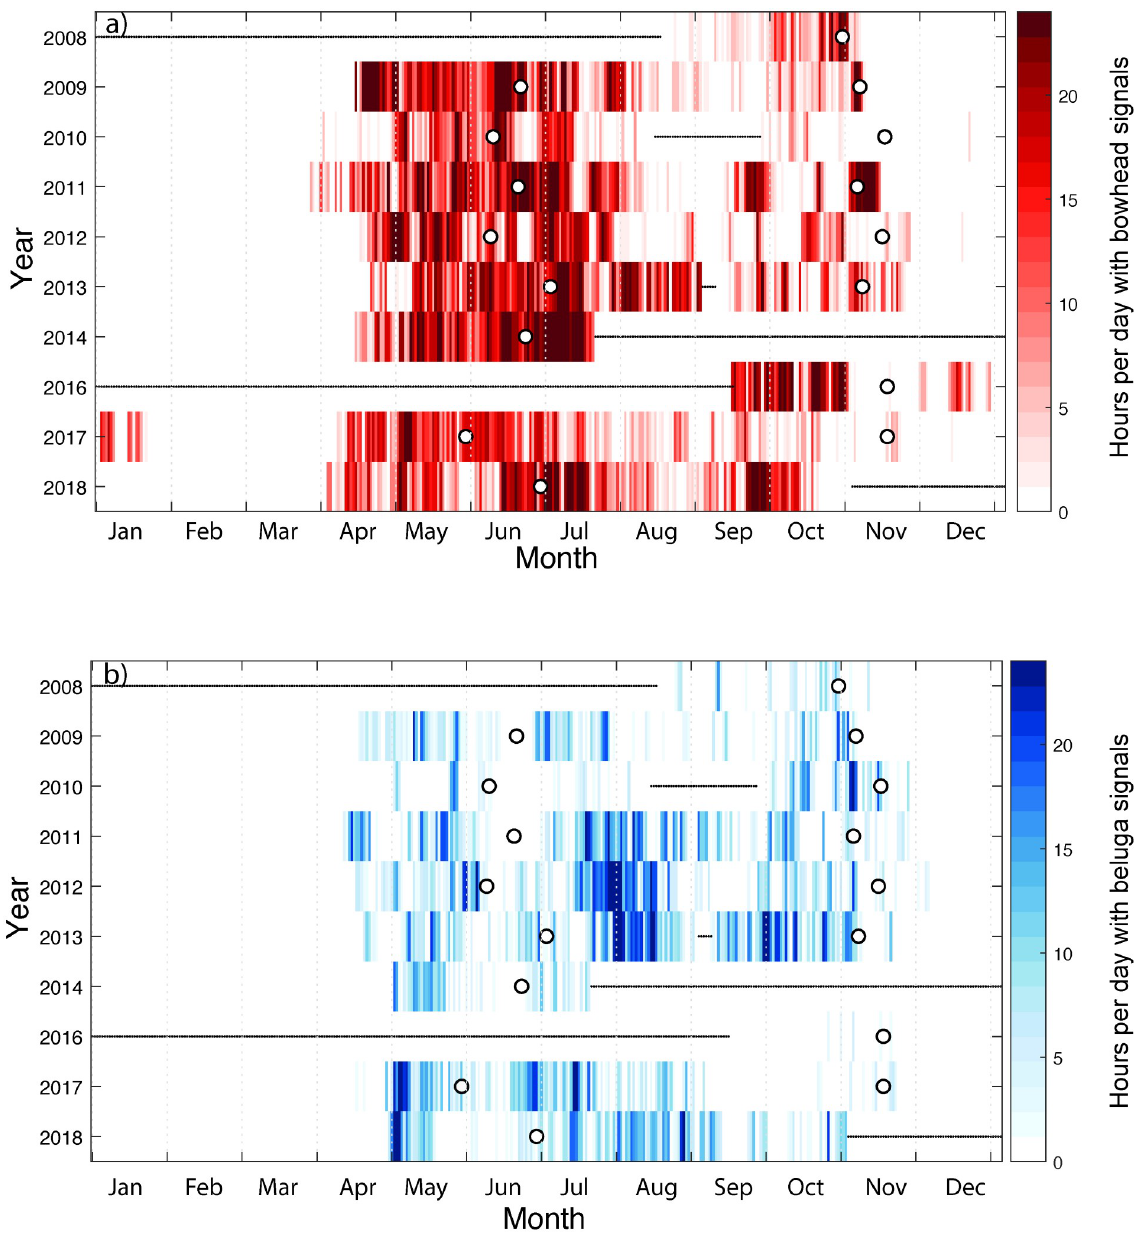
Fig 4. Heatmaps of hours per day with acoustic detections by year from 2008–2018. a) bowhead whales and b) beluga whales. Timing of melt and freeze up transitions by year are shown as white circles. Black horizontal lines indicate missing data. Note that there were no data for the entirety of 2015 so that year is not